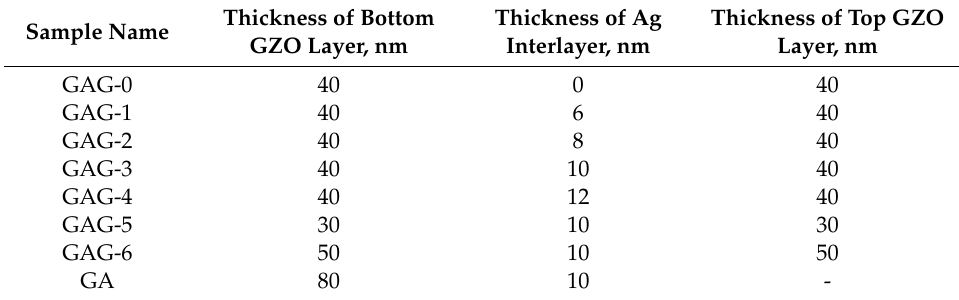
Table 1. Nomenclature of Ga-doped ZnO / Ag / Ga-doped (GZO / Ag / GZO) multilayered structures.